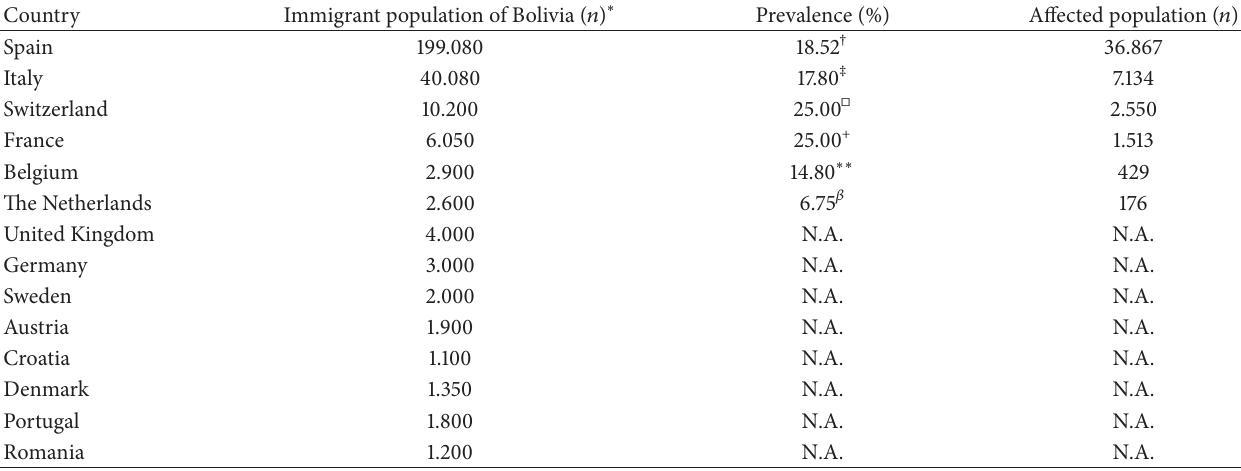
Table 1: Estimation of the Bolivian immigrant population infected with T. cruzi residing in European countries.